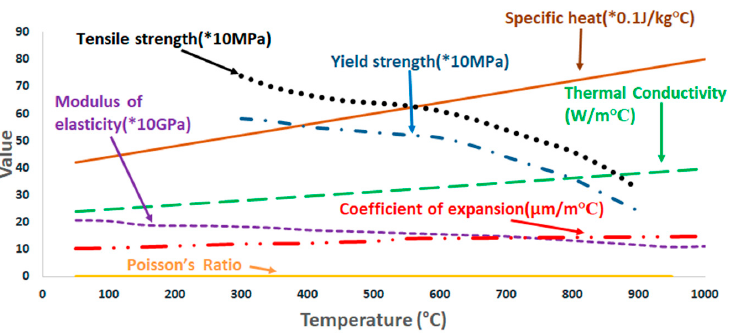
Figure 5. Physical and mechanical properties of 12Cr steel.